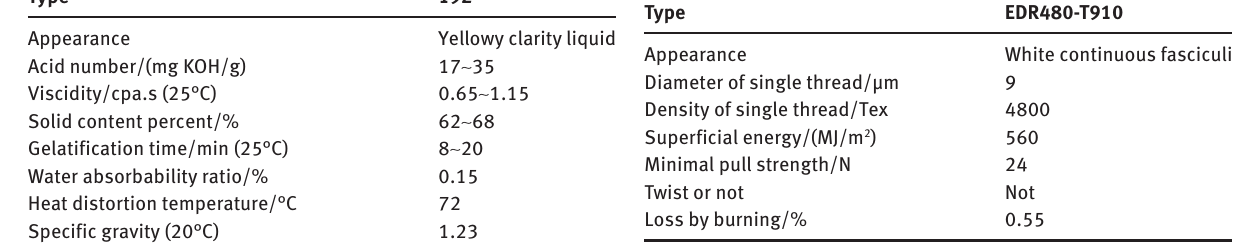
Table 1 Performance parameters of 192 unsaturated polyester resin. Table 2 Performance parameters of EDR480-T910 glass